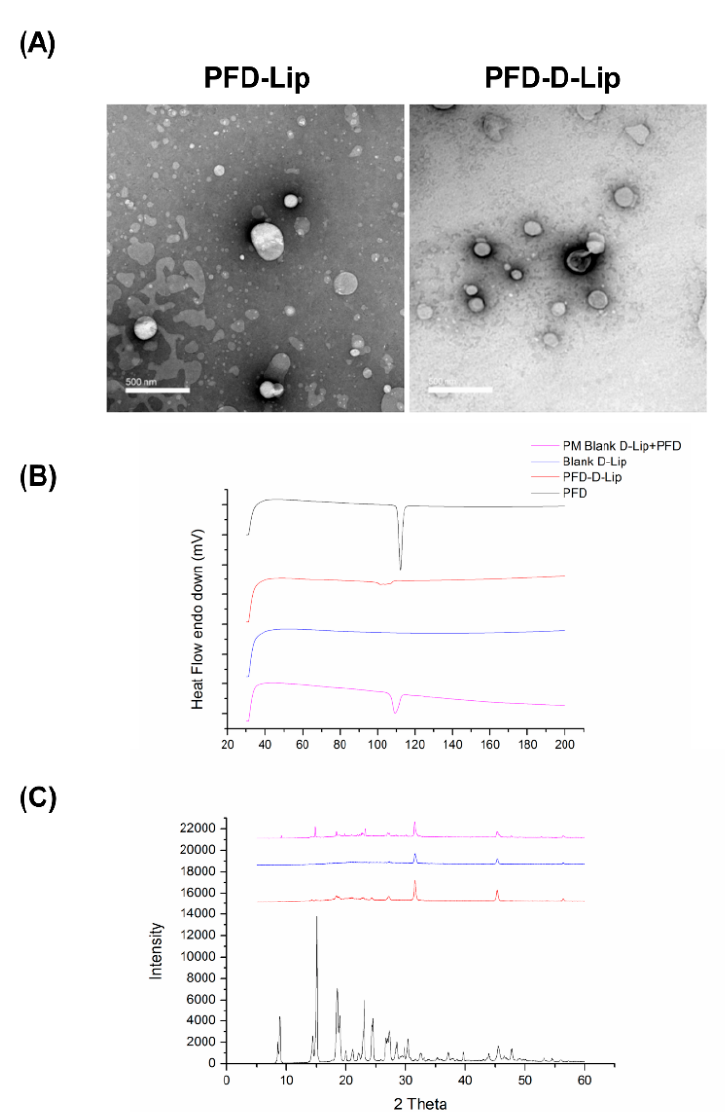
Figure 3. ( A ) Transmission electron microscopy (TEM) images of PFD–Lip and PFD–D-Lip reveal the morphology of different liposomes. Magnification 20 kX. The scale bar represents 500 nm. Vesicles are spherically shaped and uniform size distribution can be observed from PFD–D-Lip. ( B ) Thermograms of pirfenidone, pirfenidone-loaded DOTAP liposomes (PFD–D-Lip), physical